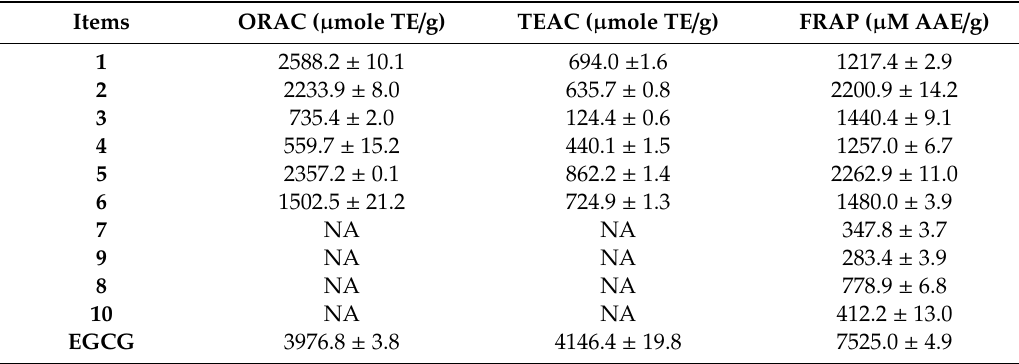
Table 4. Antioxidant activities of the isolated